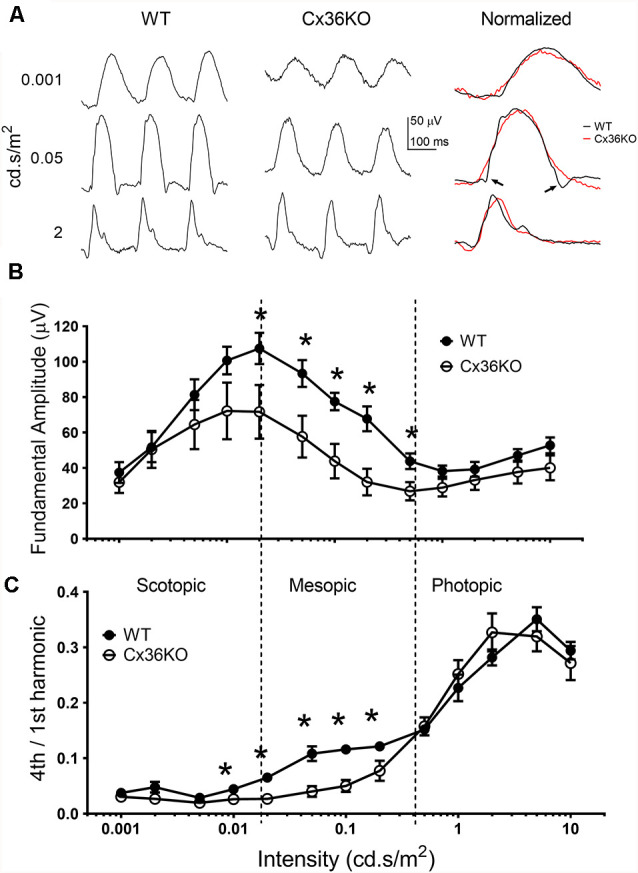
Flicker ERG responses. ERG responses elicited with 6 Hz flash flickering stimulus in the wildtype and Cx36KO mice. (A) Examples of the flicker ERG waveform at 3 stimulus intensities for a WT mouse (left panel), and a Cx36KO mouse (middle panel). Amplitude normalized waveforms are shown on the right panel, illustrating the narrower response waveform for WT (pointed by arrows) than those of the Cx36KO elicited by mesopic light stimulus (middle row). (B) The amplitude of the fundamental (6 Hz) response. (C) The ratio of the 4th harmonic (24 Hz) to fundamental response amplitudes. While both the scotopic and photopic flash intensities showed a similar 4th harmonic component for WT (n = 6) and Cx36KO (n = 4) mice, there is a much higher 4th harmonic component for WT to mesopic light intensities than in Cx36KO mice. *p < 0.05.